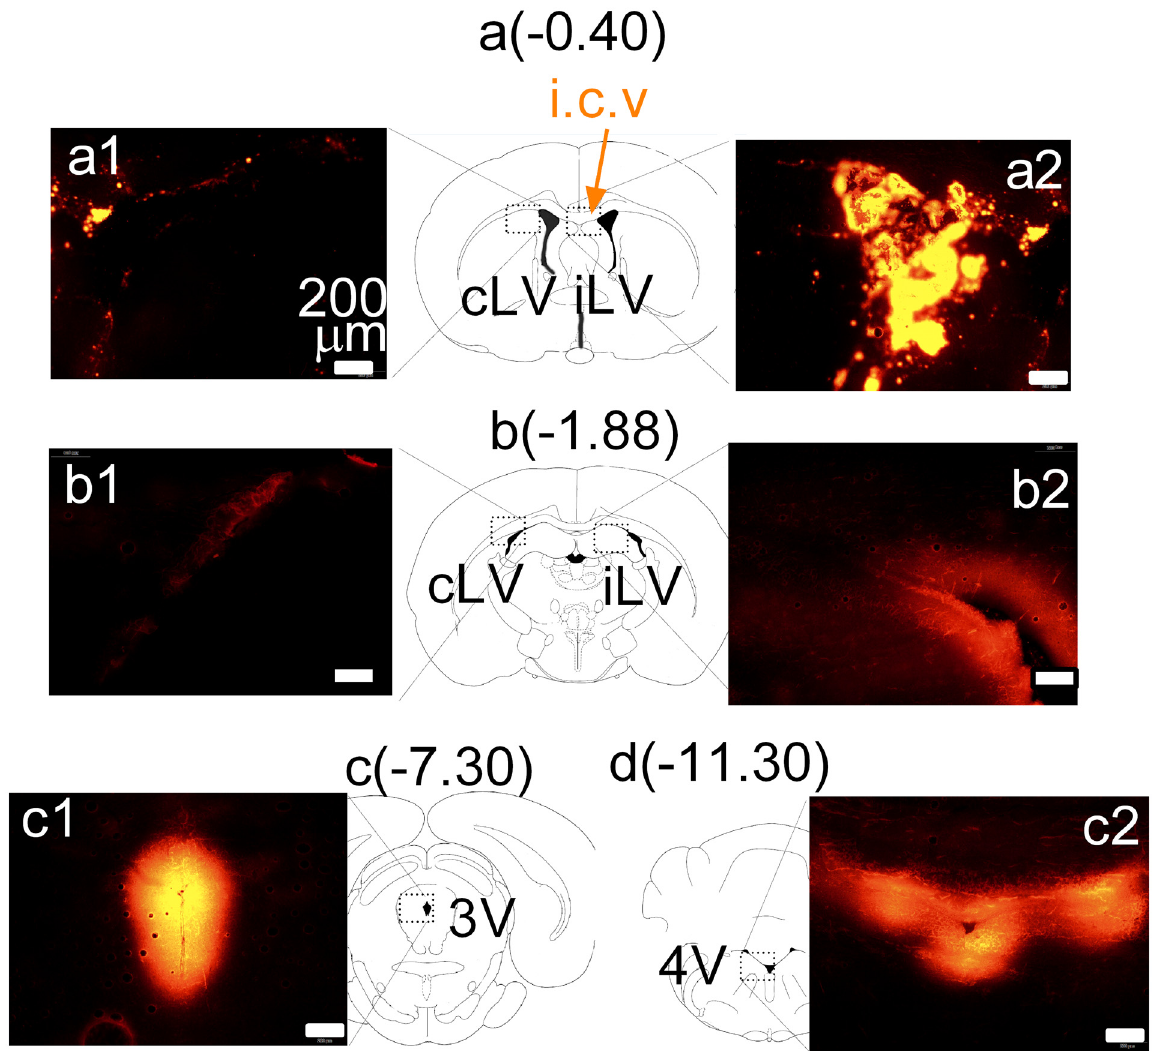
Fig 8. Relationship between intracranial administration and dye diffusion from the delivery site to the surrounding or distant tissue. The route of intracranial administration was ICV. The dyes used in this test were DiI. N = 4 rats. Atlas coordinates are in millimeters posterior to bregma at -0.40 (a), -1.88 (b), -7.30 (c), and -11.30 (d). Bars scale, 200 μ m. DiI was injected at the right LV at coordinates of AP -0.40 mm (a2). DiI density was higher in the ipsilateral LV (iLV; a2 and b2) than that in the contralateral LV (cLV; a1 and b1). DiI fluorescence was found in the LV to 3V and 4V (c1 and c2). However, diffusion of DiI to the ISF is very poor, ~200 μ m away from the CSF